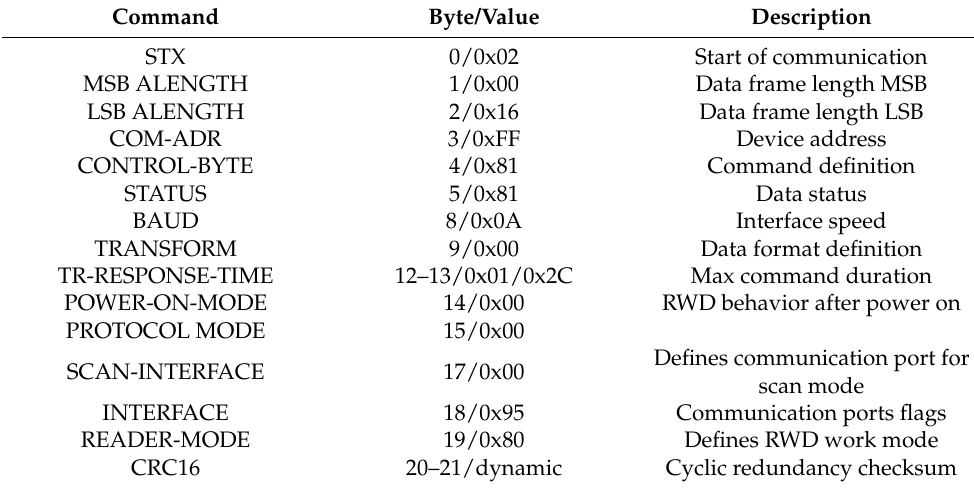
Table A1. Selected read/write device